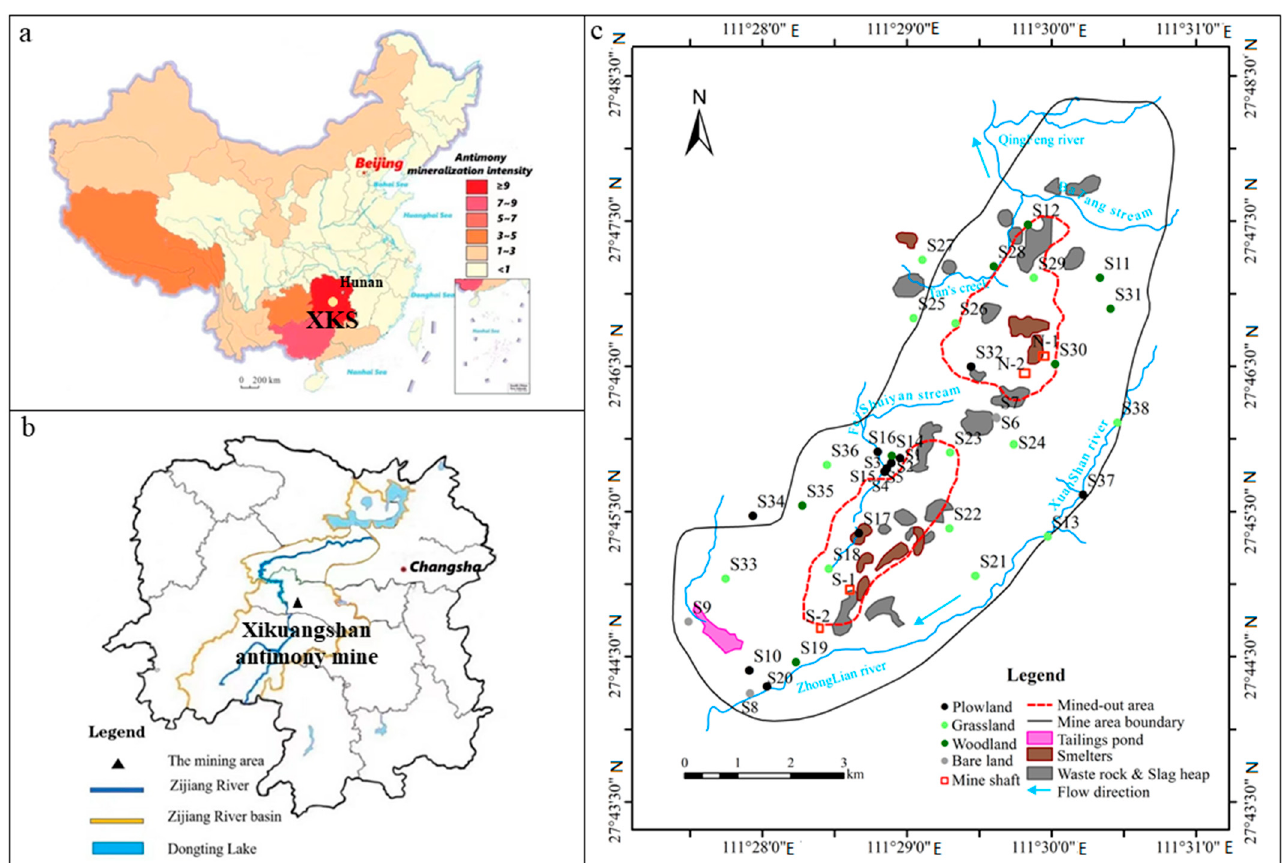
Figure 1. The location map of the study area and distribution of soil sampling sites. ( a ) antimony mineralization intensity in China and location of the Xikuangshan mine (XKS) in China; ( b ) the XKS antimony mine location in the Zijiang River basin and Hunan province; ( c ) distribution of mine activities in the XKS mine area and soil sampling sites of this